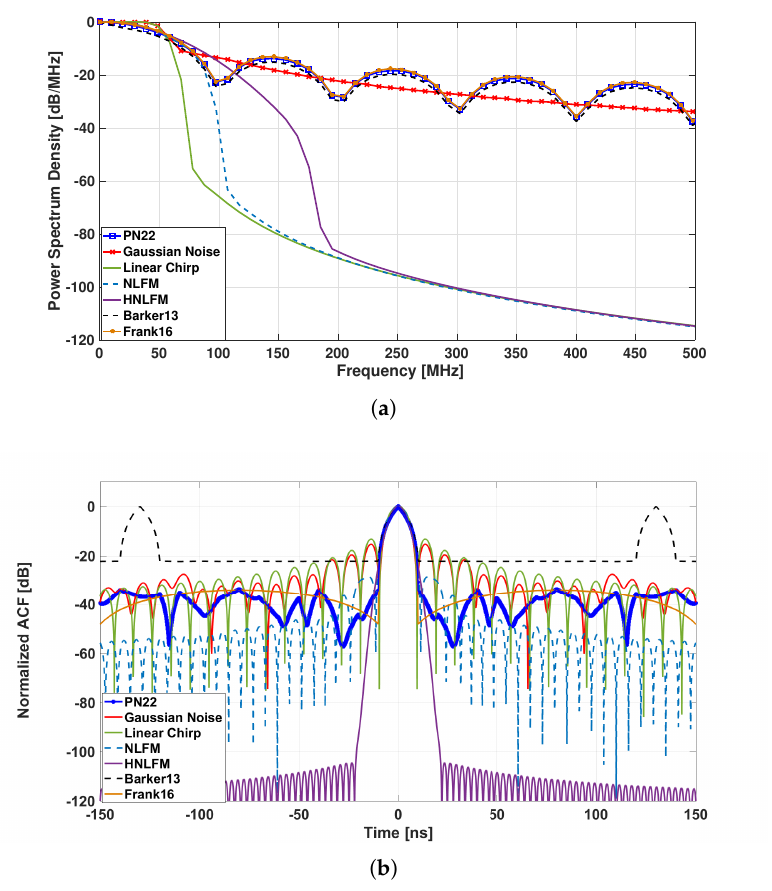
Figure 14. Power spectrum density (PSD) ( a ) and auto correlation function (ACF) ( b ) of the signals to be compared. All of them are generated using BW − 3 dB = 35 MHz and an integration time T = 50 µ s.